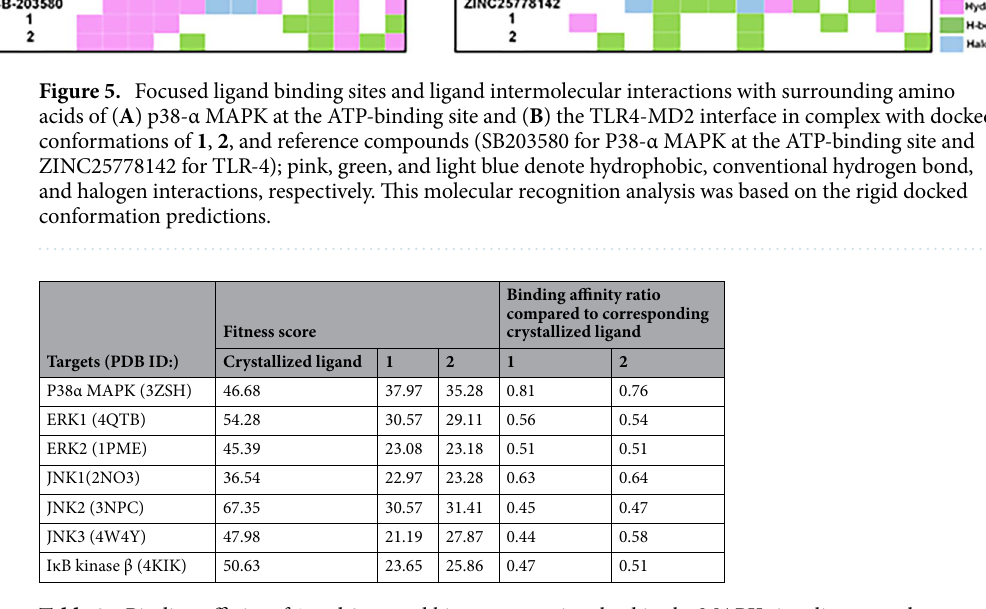
Table 2. Binding affinity of 1 and 2 toward kinase targets involved in the MAPK signaling cascade compared to the original crystallized ligand. * The equation for binding affinity ratio was fitness score of the compound divided by fitness score of crystallized